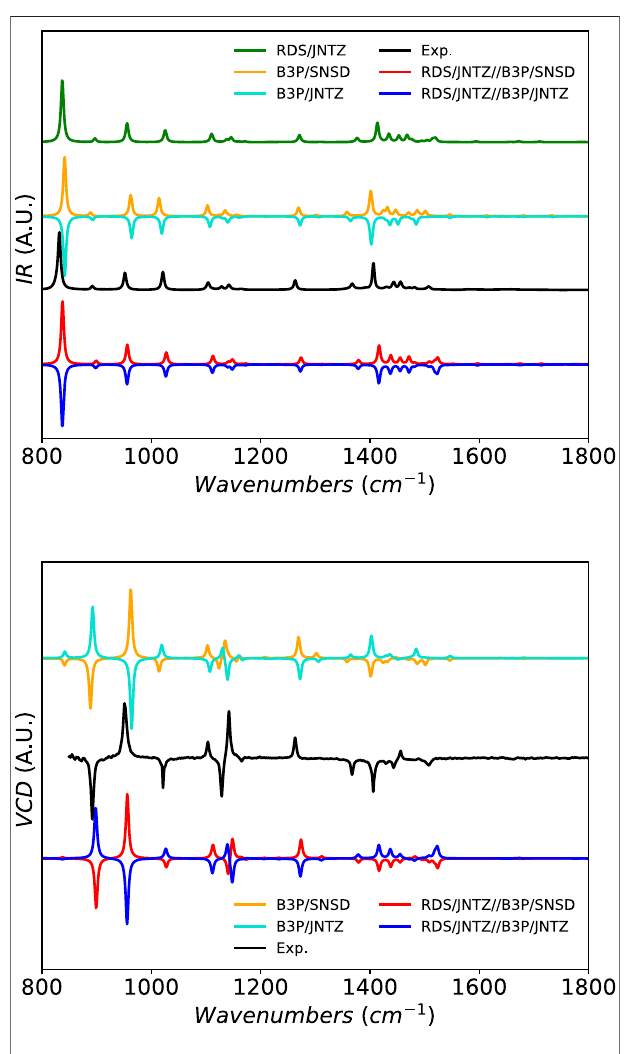
FIGURE 6 | Infrared and vibrational circular dichroism spectra of methyloxirane at the B3PW91/SNSD ( B3P/SNSD ), B3PW91/jun-cc-pVTZ ( B3P/JNTZ ), revDSD-PBEP86-D3(BJ)/jun-cc-pVTZ ( RDS/JNTZ ) and hybrid levels using the GVPT2 scheme, compared to experiment taken from (Merten et al., 2013). Theoretical line-shapes were broadened by mean of Lorentzian distribution functions with half-widths at half-maximum of 3 cm − 1 . ThespectrageneratedwiththeanharmonicconstantsattheB3PW91/jun-cc- pVTZ were inverted (intensity multiplied by − 1) to make the difference with B3PW91/SNSD more